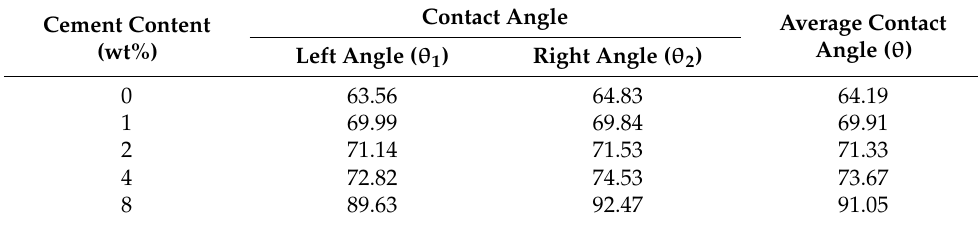
Table 1. Contact angle of pure acrylic polymer and acrylic polymer/cement